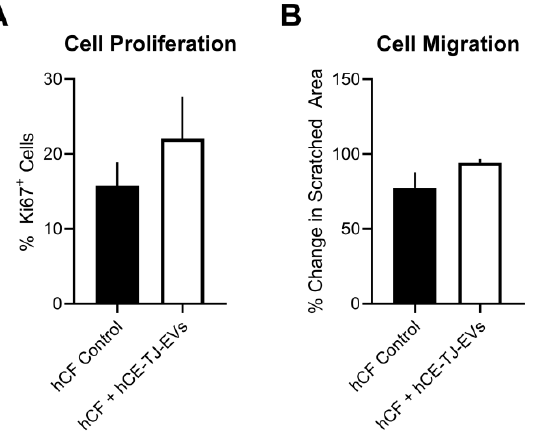
Figure 6. hCE-TJ-derived EVs do not significantly influence corneal fibroblast proliferation or migration. ( A ) hCF proliferation based on the marker of proliferation (Ki67 + ) staining at 24 h. n = 5 – 6. ( B ) Relative change in the wounded area in hCF ± hCE-TJ-EVs at 24 h. n = 3. Error bars represent SEM.